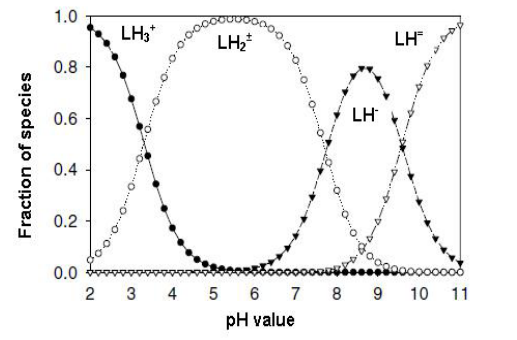
Figure 1. Influence of the pH value on the distribution of tetracycline species in aqueous solution after